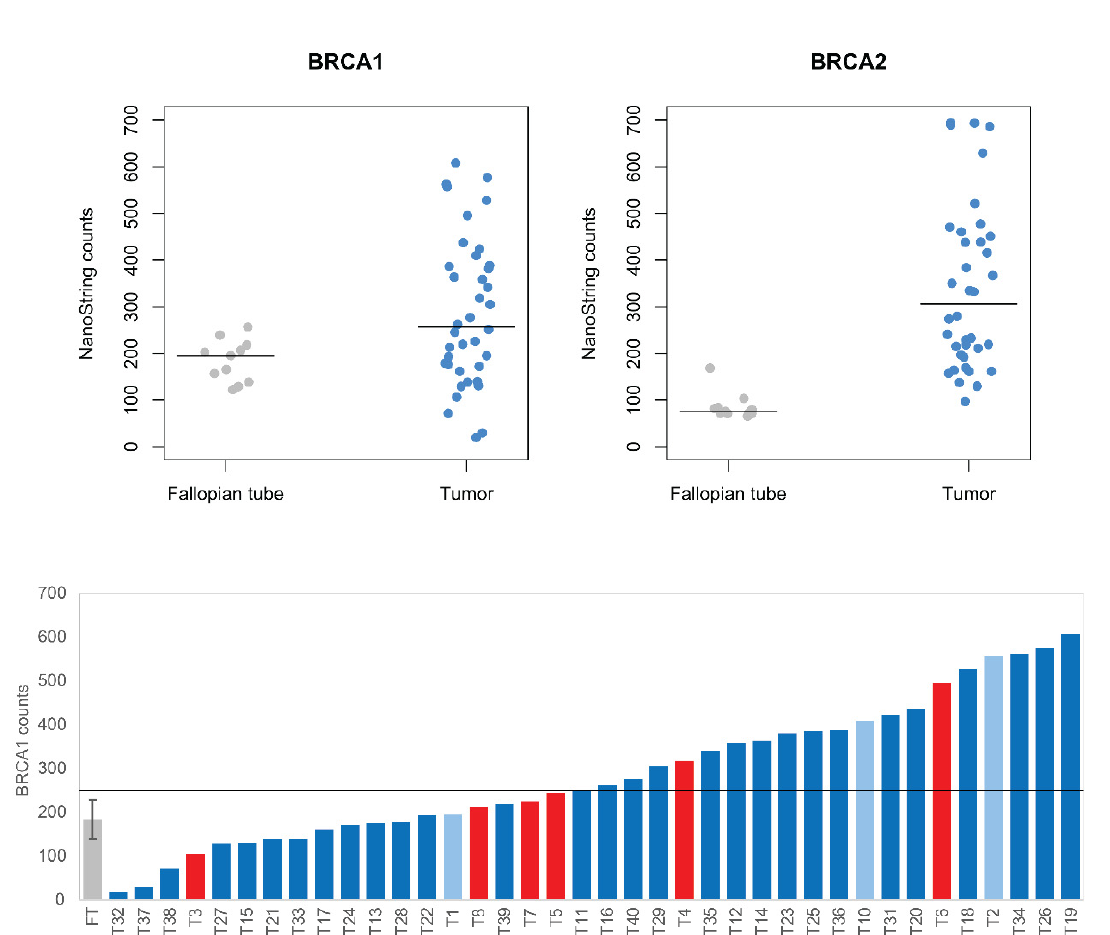
Figure 1. Expression level of BRCA1 and BRCA2 genes in 11 normal fallopian tubes and 38 tumor samples analyzed with the NanoString nCounter assay. Tumor samples showed both higher median expression levels as well as greater variabil- ity. ( A ) NanoString counts for BRCA1 and BRCA2 , in both fallopian tube and tumor samples. The horizontal bar marks the median. ( B , C ) Individual mRNA counts for each tumor (T) are shown ordered from lowest to highest BRCA1 ( B ) and BRCA2 ( C ) expression levels. Tumors with identified mutations are highlighted (red, frameshift mutations; yellow, Por- tuguese BRCA2 founder mutation; light blue, missense mutations). For the 11 normal fallopian tube (FT) samples, the mean and standard deviation are depicted. Next, we focused on tumors harboring mutations in the BRCA1/2 genes (Figure 1B,C). Ten tumors had frameshift mutations located in either BRCA1 exon 11 or BRCA2 exons 10 and 11 (Supplementary Figure S3). These mutations generate PTCs and are pre- dicted to elicit NMD according to recently validated rules [30]. Indeed, the PTCs were more than 50–54 bp upstream of the last exon-exon junction, both BRCA1 and BRCA2 genes comprised more than two exons, and the PTCs were more than 200 bp downstream